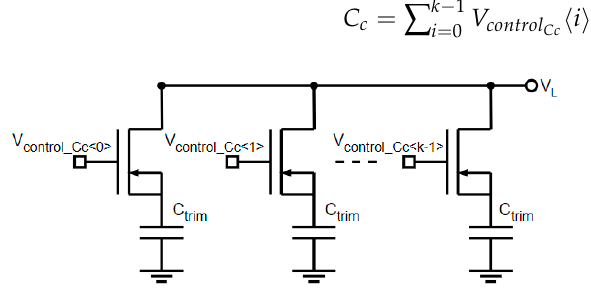
Figure 6. Trimming capacitor array.